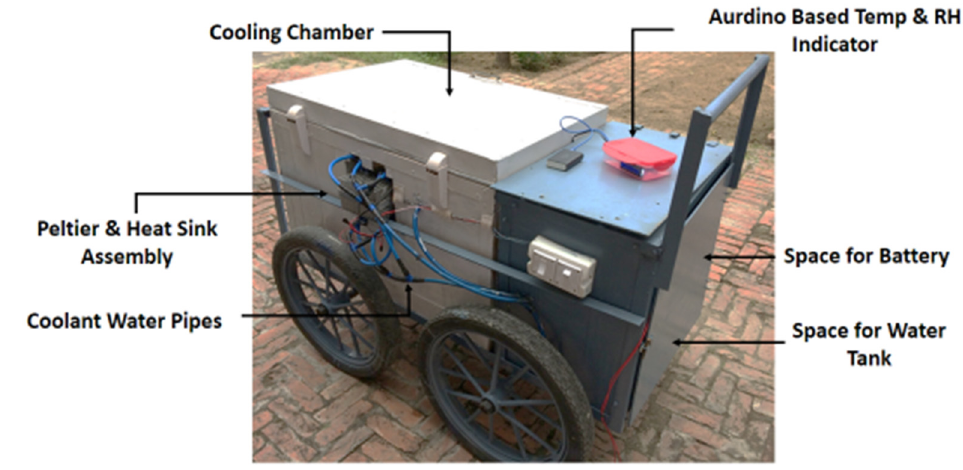
Figure 1. A complete view of the developed thermoelectric refrigeration system.